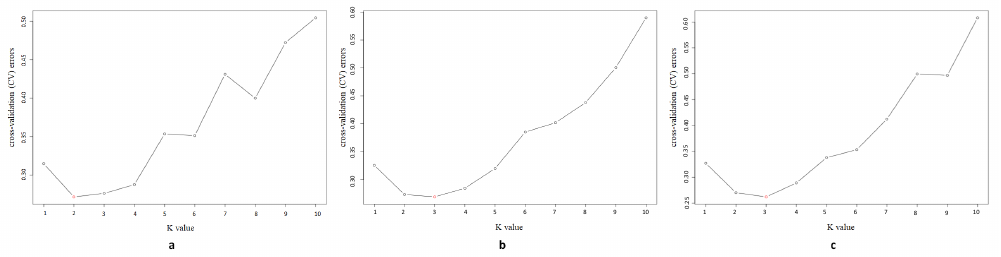
Figure 3. Cross-validation (CV) errors of di ff erent K values (k = 1–10) at di ff erent temperatures. Red circles represent CV errors of best K-value. ( a ) CV errors at 5 ◦ C. ( b ) CV errors at 20 ◦ C. ( c ) CV errors at 35 ◦ C.